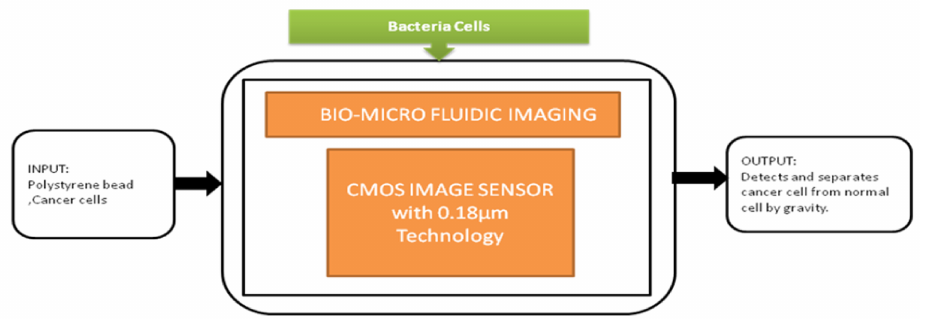
Figure 41. Cancer cell separation by gravity from the normal cell through biomicrofluidic imaging device.